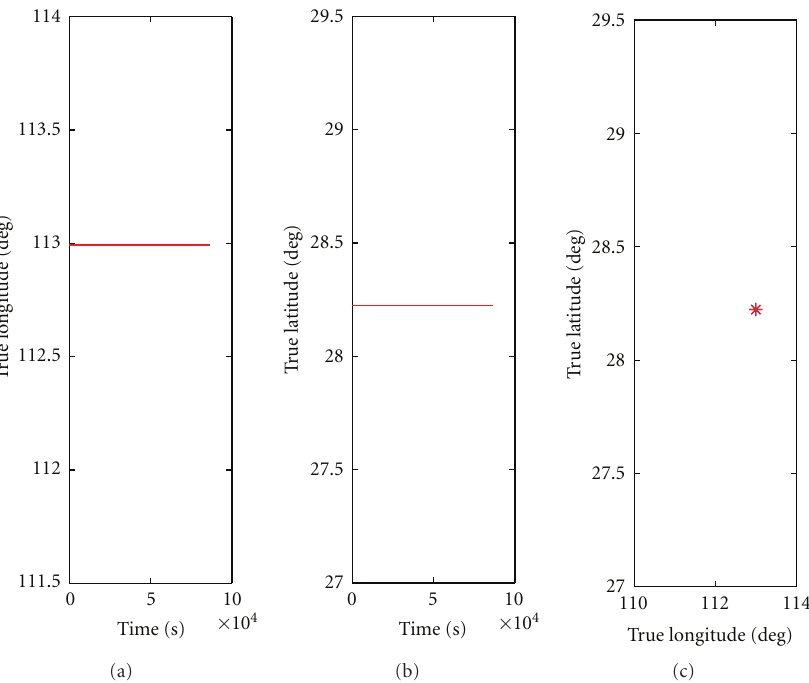
Figure 21: The trajectory of real data set A.